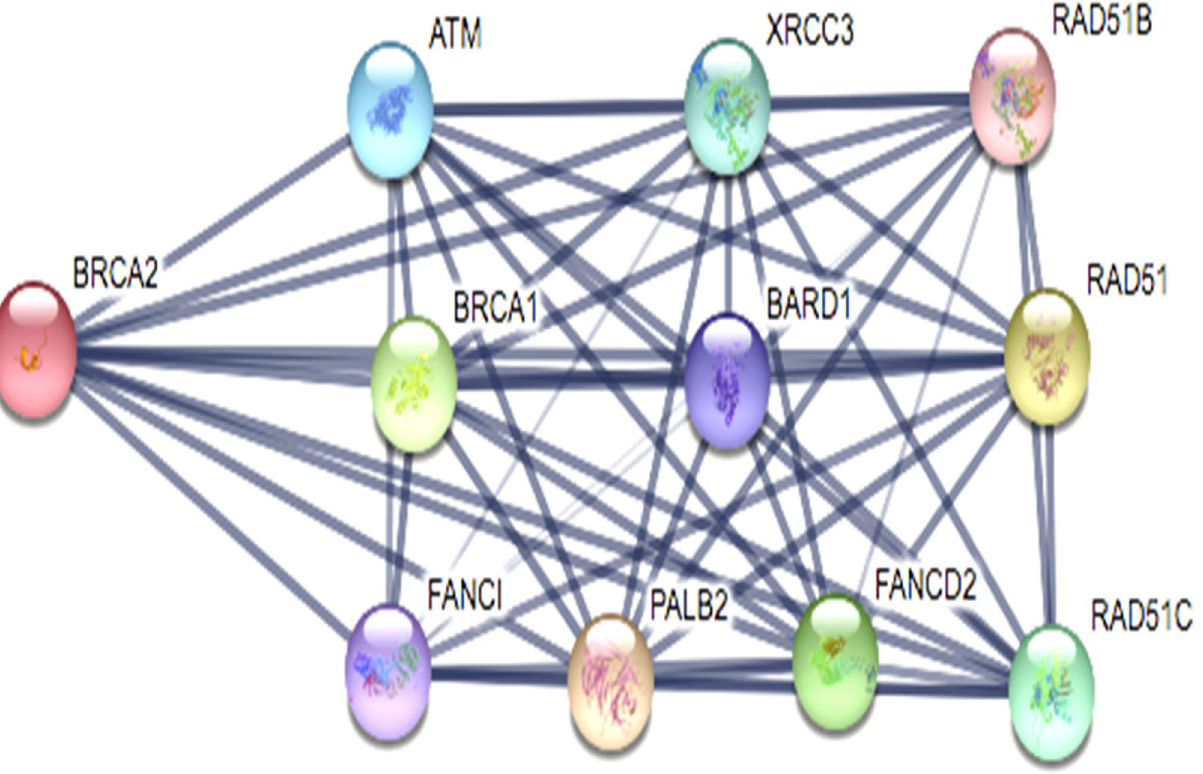
Figure 7. Protein–protein interaction study for the selection of BRCA2 for SeNPs